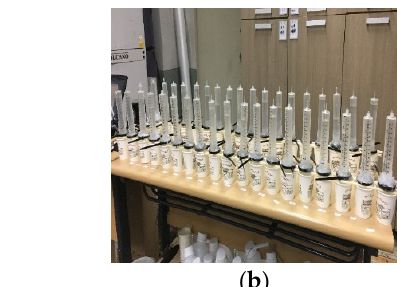
Figure 5. Splitting tensile strength re-load test: ( a ) fracture specimen for re-load test, ( b ) re-load test of fractured specimens after the healing period.